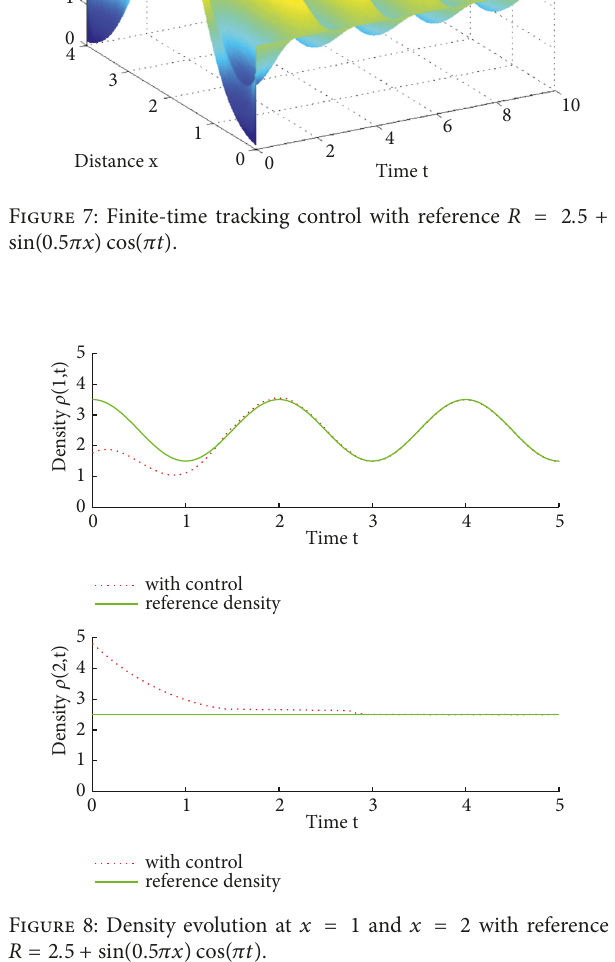
Figure 7. Figure 8 illustrates the density evolution at 𝑥 = 1 and 𝑥 = 2 with reference 𝑅 = 2.5+ sin (0.5𝜋𝑥) cos (𝜋𝑡) . The density